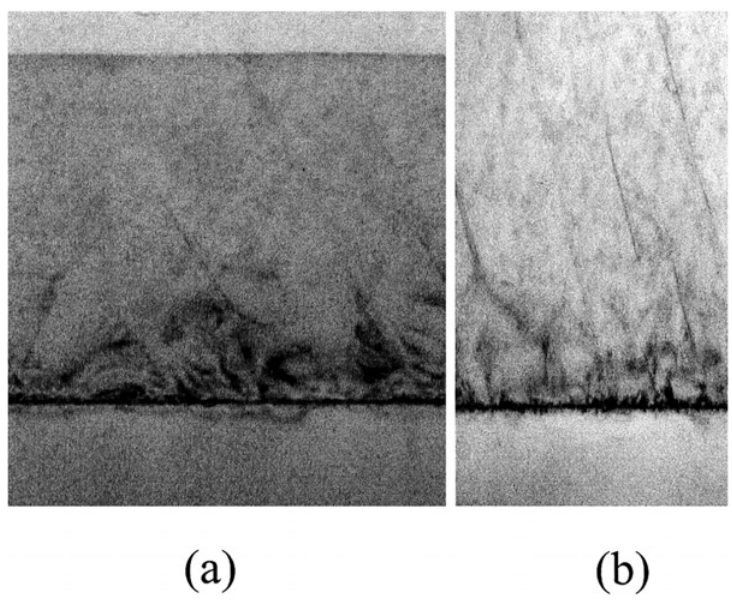
FIGURE 7 (a) The cross-sectional view of TEM image with the growth temperature of 480 (cid:1) C, and (b) partially enlarged TEM image. The diffraction pattern of this sample is also shown in the inserted diagram.